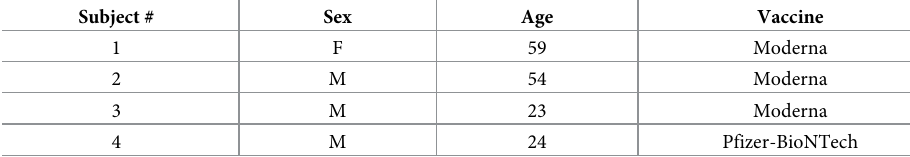
Table 1. Study subjects that received COVID-19 mRNA vaccine.